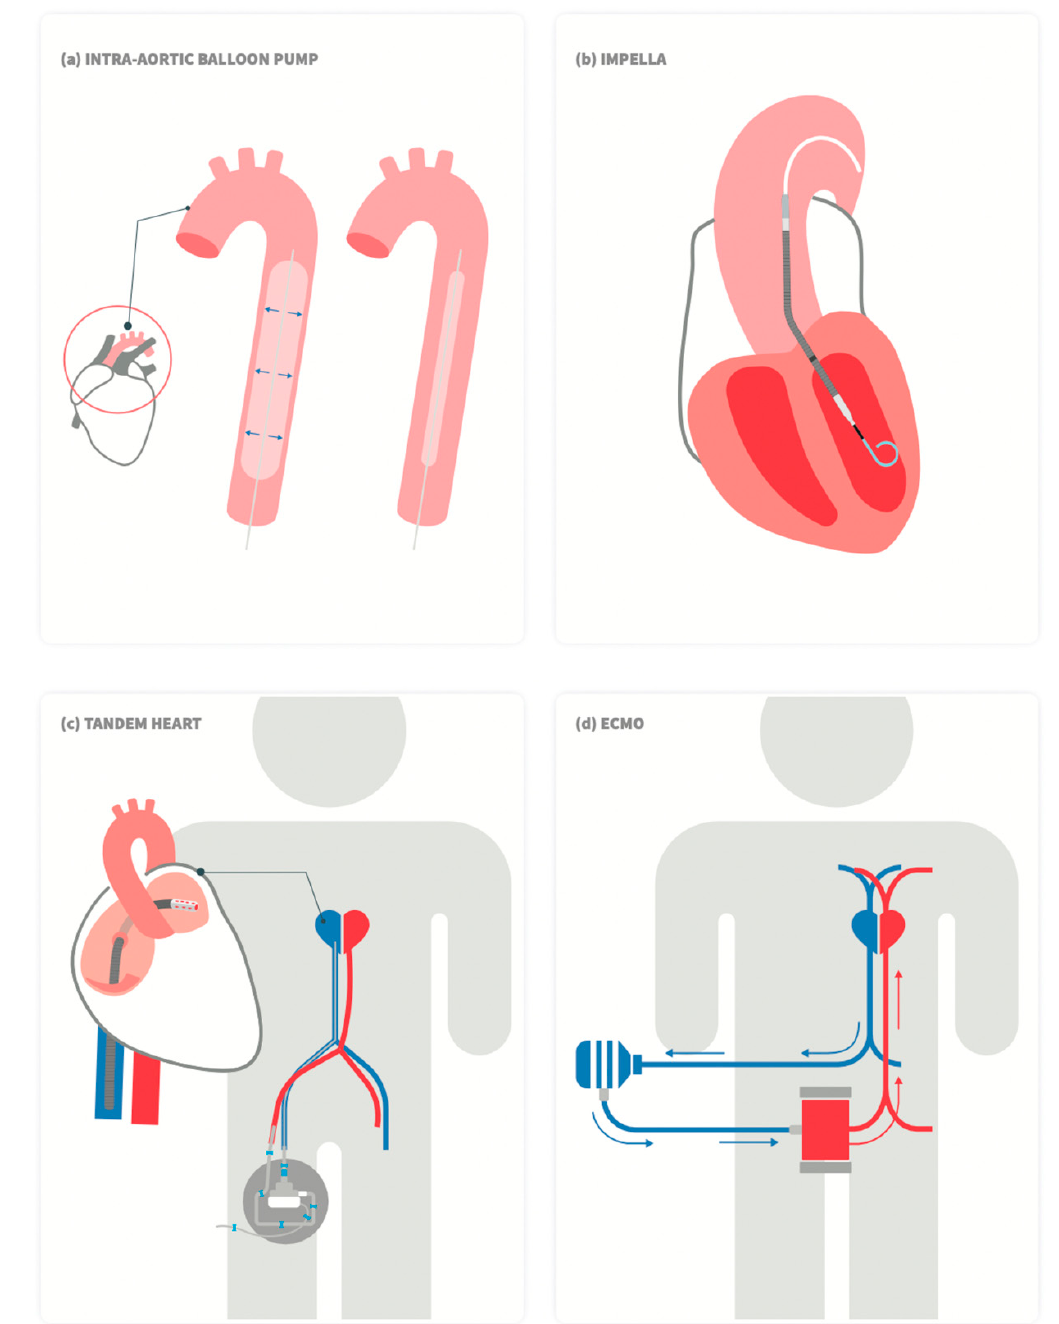
Figure 1. Schematic drawing of commercially available left ventricular percutaneous mechanical support devices. ( a ) Intra-aortic balloon pump, ( b ) Impella, ( c )TandemHeart, and ( d ) Veno-arterial (VA) extracorporeal membrane oxygenation (ECMO).